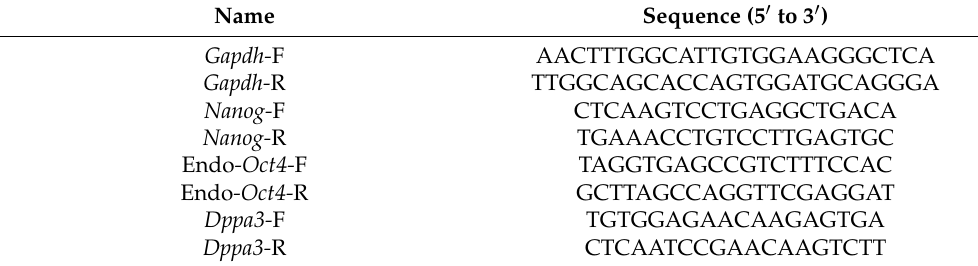
Table 5. Information on the